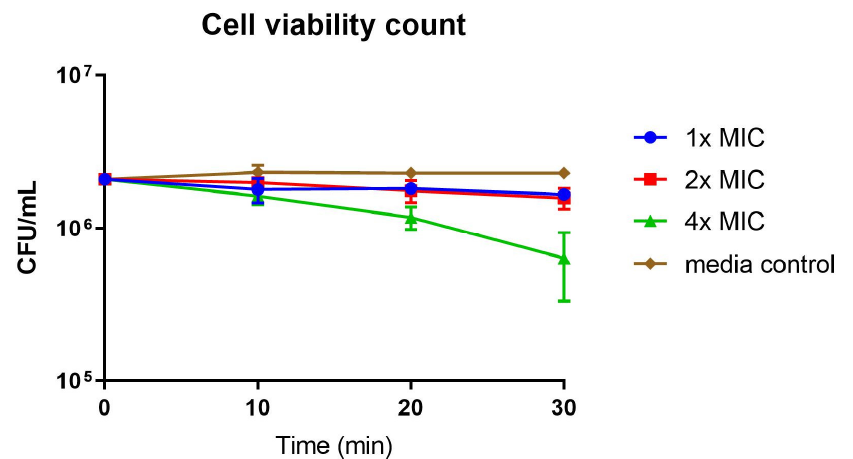
Figure 6. Cell viability count of S. aureus with the treatment of compound 17d at 1×, 2× and 4× of its MIC.